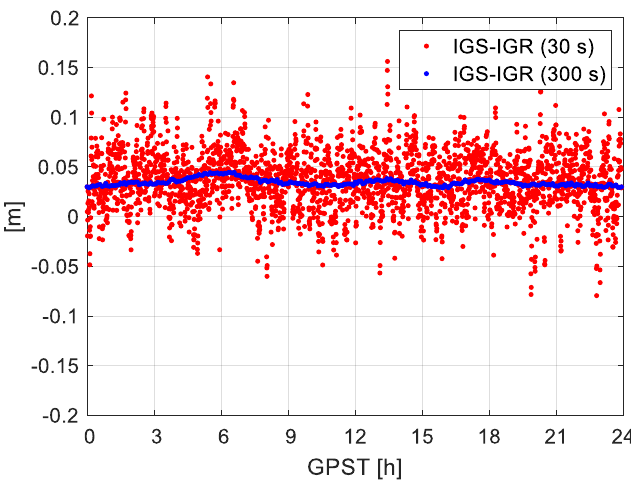
Figure 7. Differences in the between-satellite clocks for G02 and G32 between the IGS final and rapid clocks.